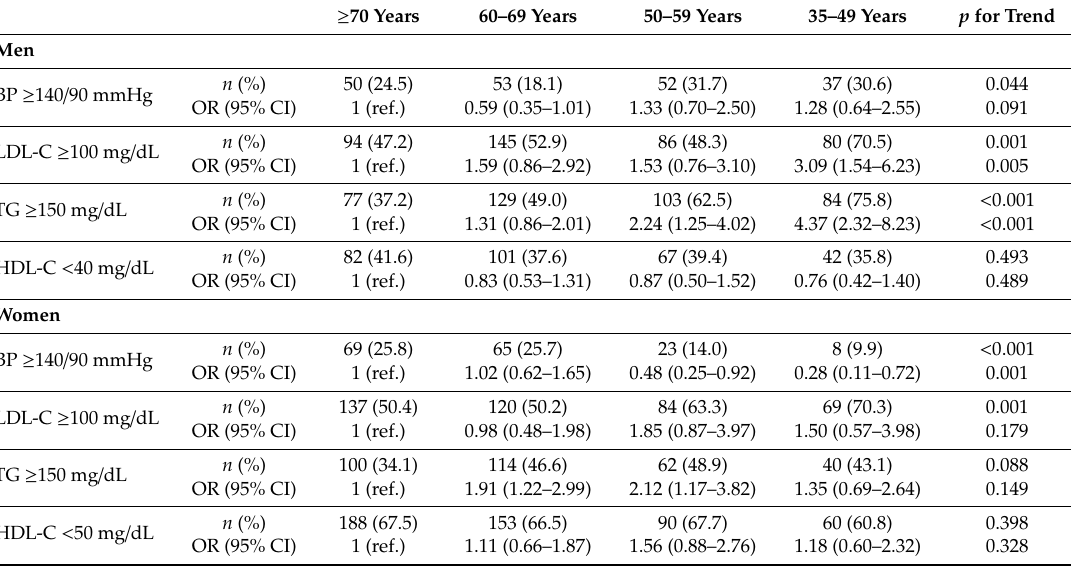
Table 4. Control of cardiometabolic parameters according to age groups among patients with